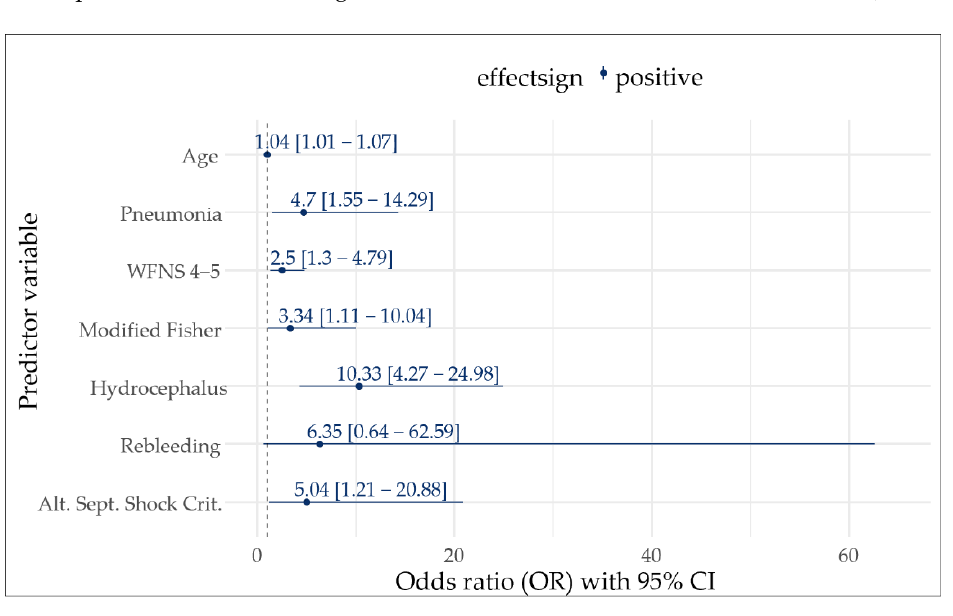
Figure 2. Multivariate logistic regression model-based odds ratios with 95% CI for functional outcome at discharge. Poor functional outcome was defined as modified Rankin Scale > 3. Displayed are only those variables that remained in the model during stepwise variable selection process.